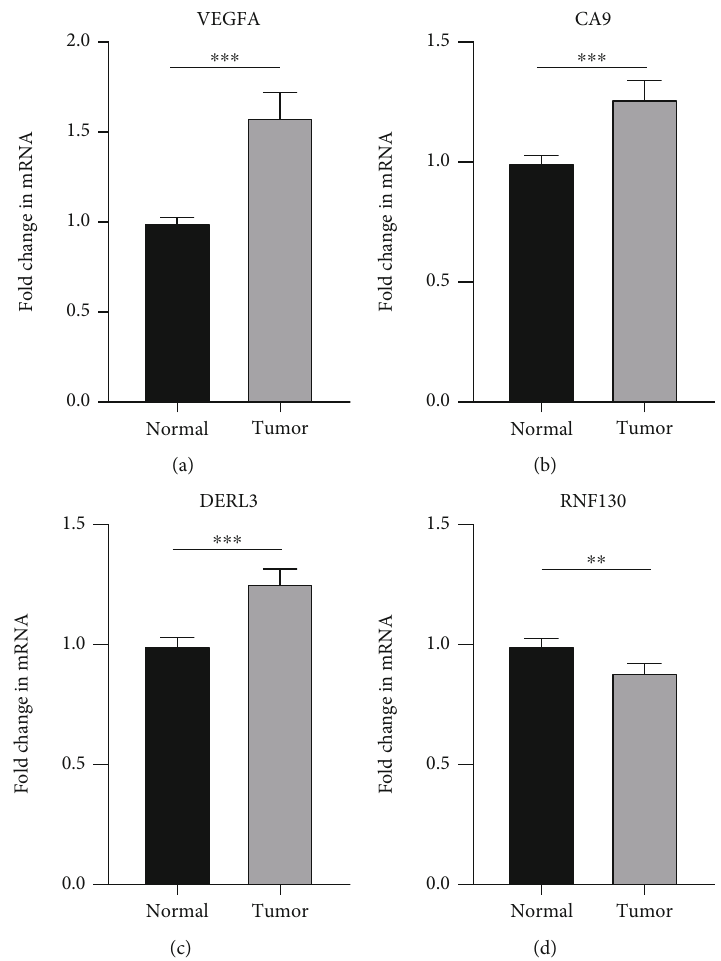
Figure 11: qRT-PCR. (a – d) The results showed that the expression of VEGFA, CA9, and DERL3 in cervical cancer was signi fi cantly higher than that in normal samples, while the expression of RNF130 in cervical cancer was lower than that in the normal group. ∗ P < 0 : 05 ; ∗∗ P < 0 : 01 ; ∗∗∗ P < 0 : 001